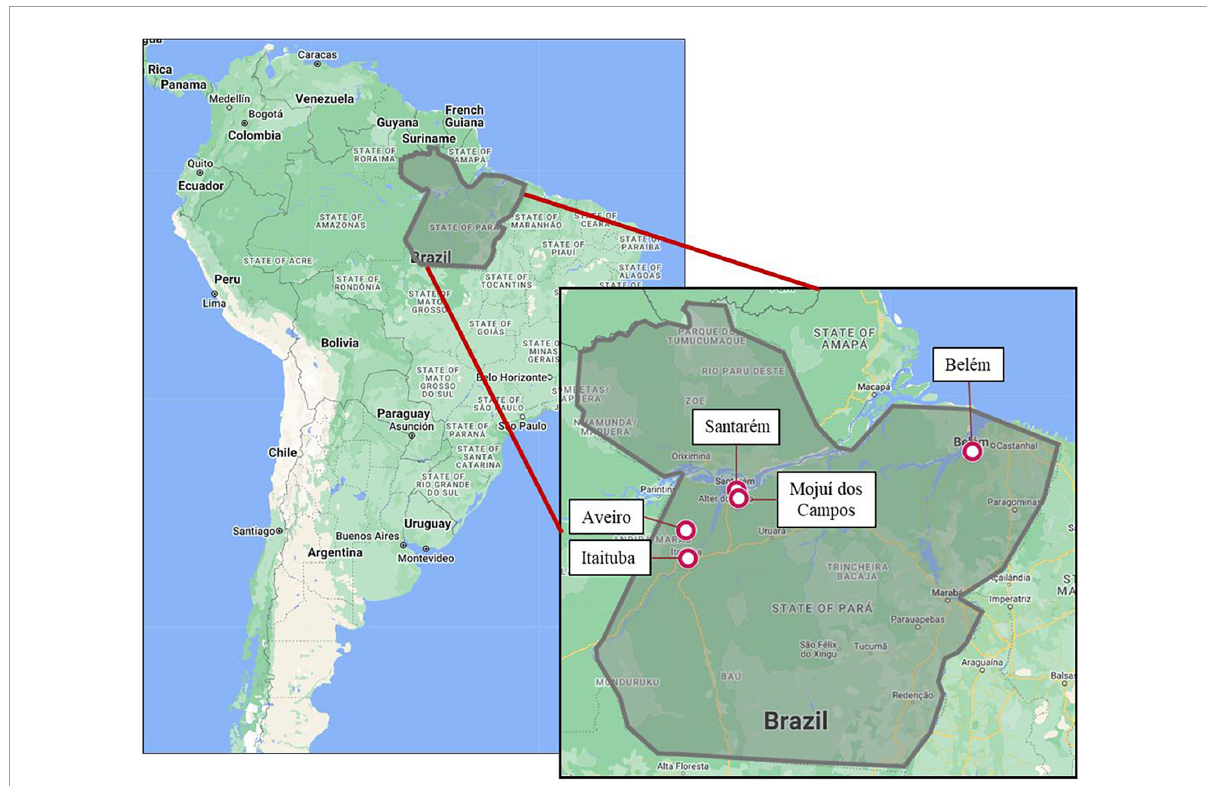
FIGURE2 Visited areas during the fieldwork, including Pará’s capital (Belém) and four municipalities in the western part of the state. Santarém is a regional hub, while the Land Reform settlements we visited are in the municipalities of Aveiro, Itaituba, and Mojuí dos Campos.